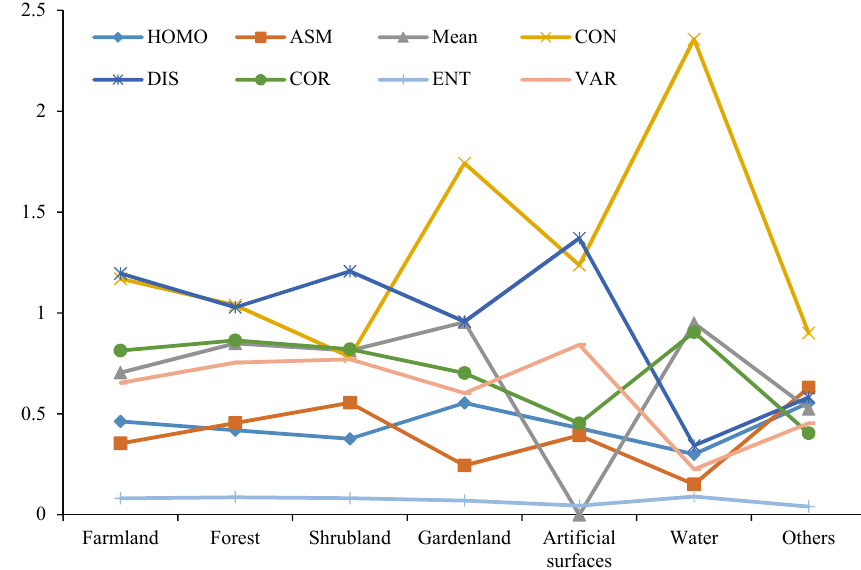
Figure 10. Texture values of land-cover types based on ALOS-2.